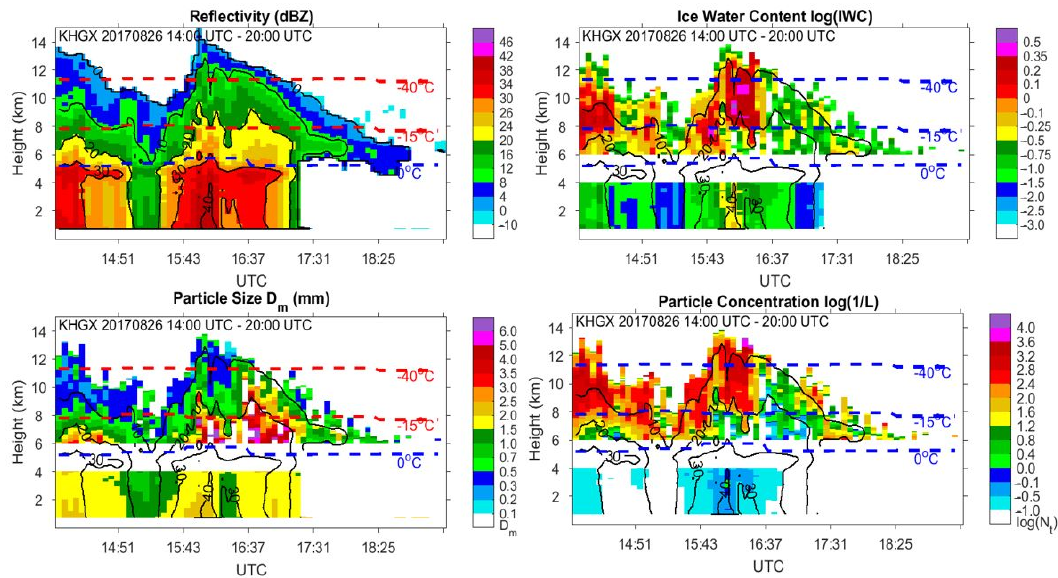
Figure 17. Columnar vertical profiles (CVPs) of Z H , IWC / LWC, D m , and N t in the outer rain band of Hurricane Harvey from the perspective of the KHGX WSR-88D radar in Houston. The location of the column base is shown with the white rectangle in Figure 15 (right panel). Overlaid are contours of Z H every 10 dBZ.